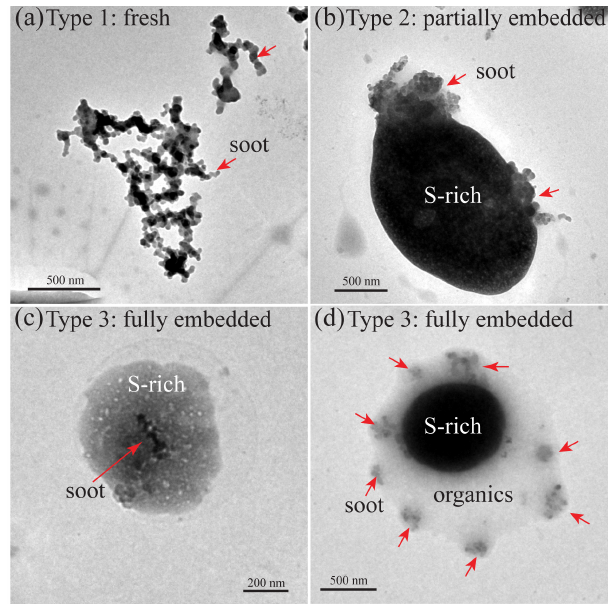
Figure 3. Morphology of soot-bearing aerosol particles: (a) fresh chainlike soot aggregates with no visible coating; (b) partially em- bedded soot: part of the soot particle was coated by secondary aerosols; (c) fully embedded soot: the whole soot particle was en- capsulated by secondary aerosols; (d) a subtype of fully embedded soot: individual soot particles were only embedded in the organic coating on a sulfur-rich